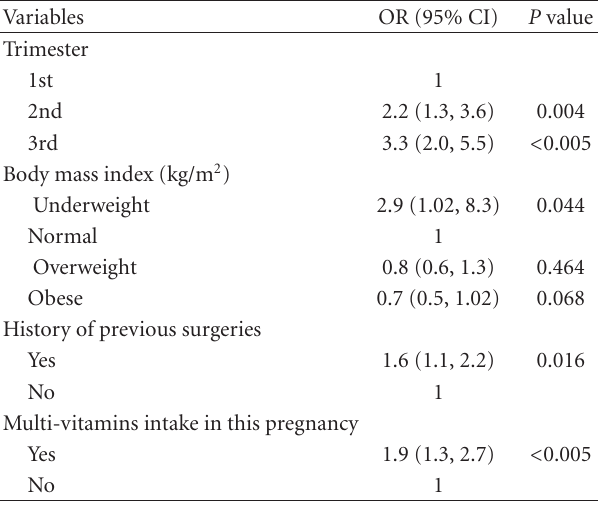
Table 5: Multivariate analysis of factors associated with anemia.